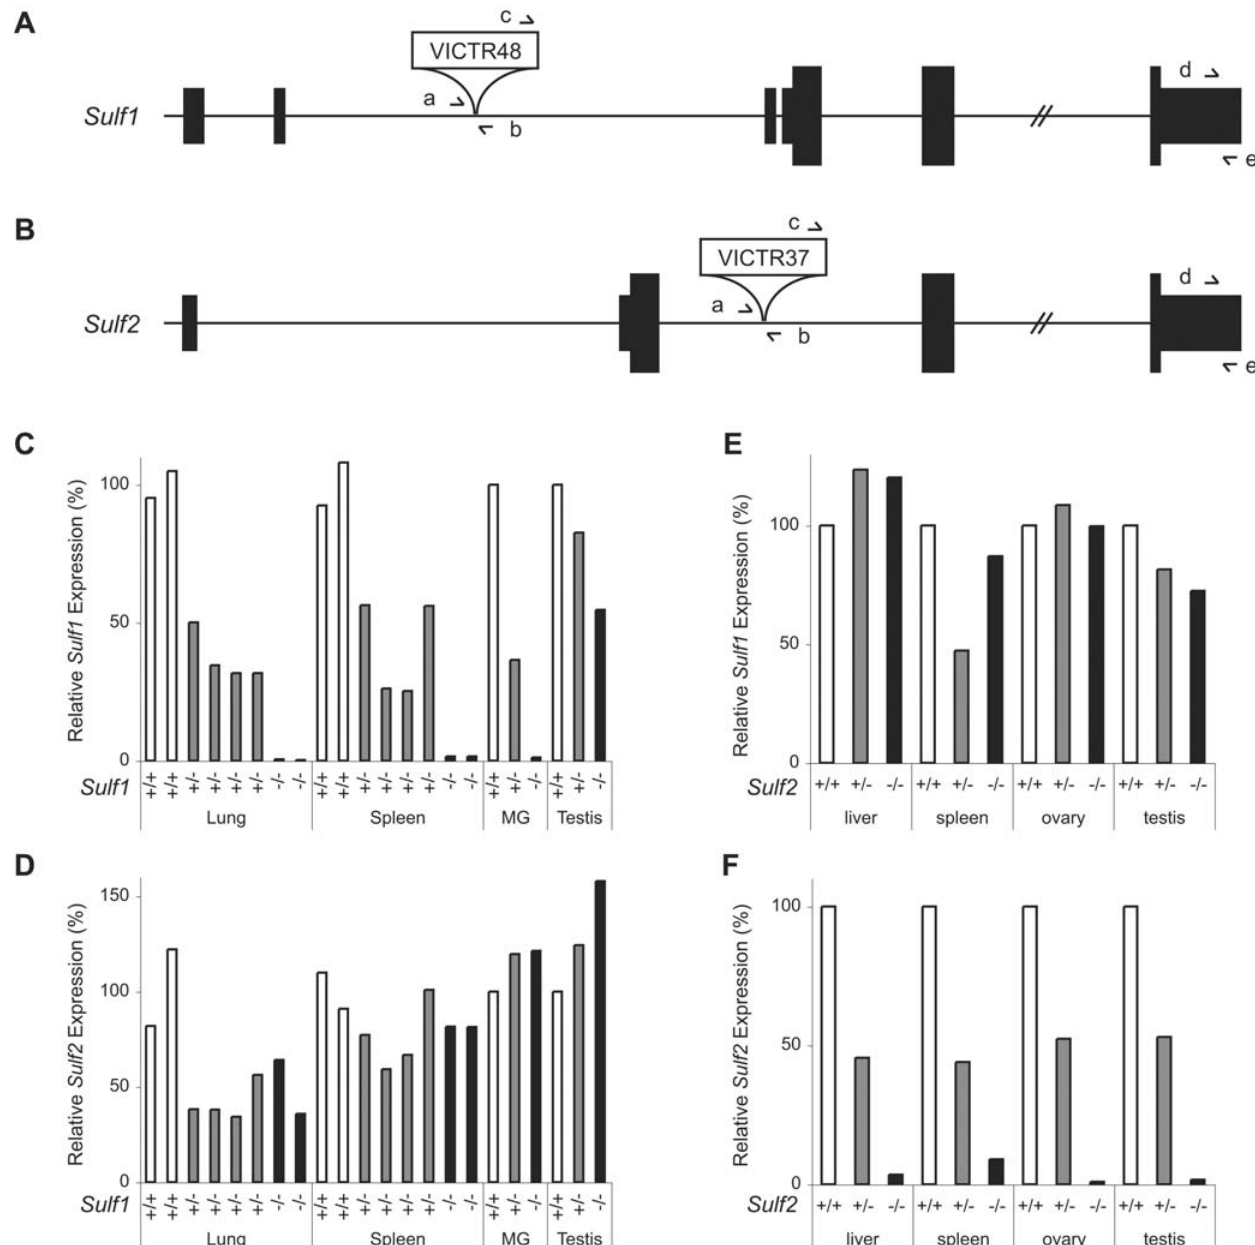
Figure 1. Sulf1and Sulf2gene trap alleles are hypomorphic. (A) Sulf1 retroviral insertion gene trap allele. The VICTR48 retrovirus inserted into position 12,733,618 of chromosome 1 (February 2006 (mm8) assembly of the mouse genome, UCSC Genome Browser), which corresponds to intron 2 of Sulf1 . Primers a , b , and c correspond to Sulf1-F, Sulf1-R1, and LTR, respectively, and were used to genotype the mice. Primers d and e in the 3 9 untranslated region refer to Sulf1-4535F and Sulf1-4611R, which were used for Q-RT-PCR amplification of the Sulf1 transcript. The position of the open reading frame is indicated by the taller boxes; the untranslated region is represented by the shorter boxes. Not to scale. (B) Sulf2 retroviral gene trap allele. The VICTR37 retrovirus inserted into position 165,818,084 of chromosome 2, which is intron 1 of Sulf2 . Primers a, b , and c correspond to Sulf2- F2, Sulf2-R, and LTR2, respectively, and were used to genotype the mice. Primers d and e in the 3 9 untranslated region refer to Sulf2-3364F and Sulf2- 3428R, which were used for Q-RT-PCR amplification of the Sulf2 transcript. (C and D) Q-RT-PCR analysis of Sulf1 (C) and Sulf2 (D) in tissues from mice with different Sulf1 genotypes (white bars, Sulf1 + / + ; grey bars, Sulf1 + /- ; black bars, Sulf1 -/- ). The Cycle to Threshold (Ct) values for duplicate or triplicate samples were averaged. Each bar represents a single animal. After normalization to GAPDH or RPL19, relative Sulf1 expression levels (compared to an average of the two WT littermate controls analyzed) were calculated based upon the 2 - DD Ct method [21]. MG refers to mammary gland. (E and F) Q- RT-PCR analysis of Sulf1 (E) and Sulf2 (F) expression in tissues from Sulf2 + / + , Sulf2 + /- , or Sulf2 -/- adult mice. Analysis was done as described above for the Sulf1 mice. Abbreviation used: MG refers to mammary gland tissue.